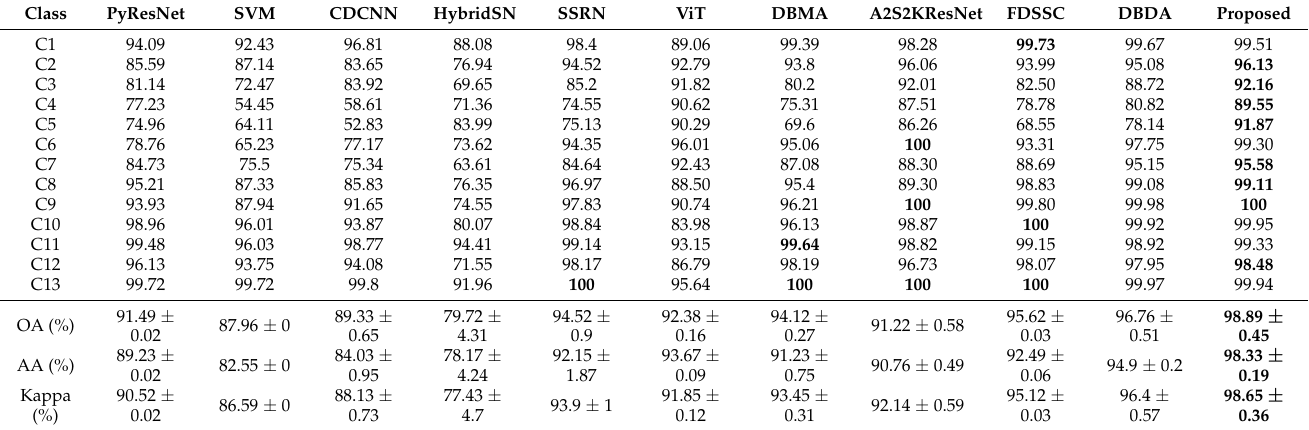
Table 8. KPIs (OA, AA, and kappa) on the Kennedy Space Center (KSC) dataset with 5% training samples.